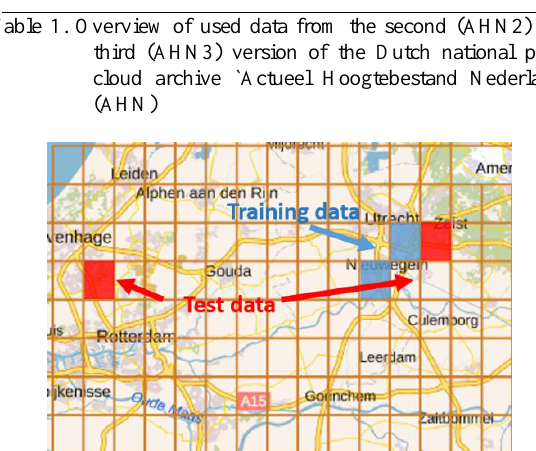
Figure 1. Map of the AHN sections selected as case study. Training data from the surroundings of Utrecht, and test data also from the area of